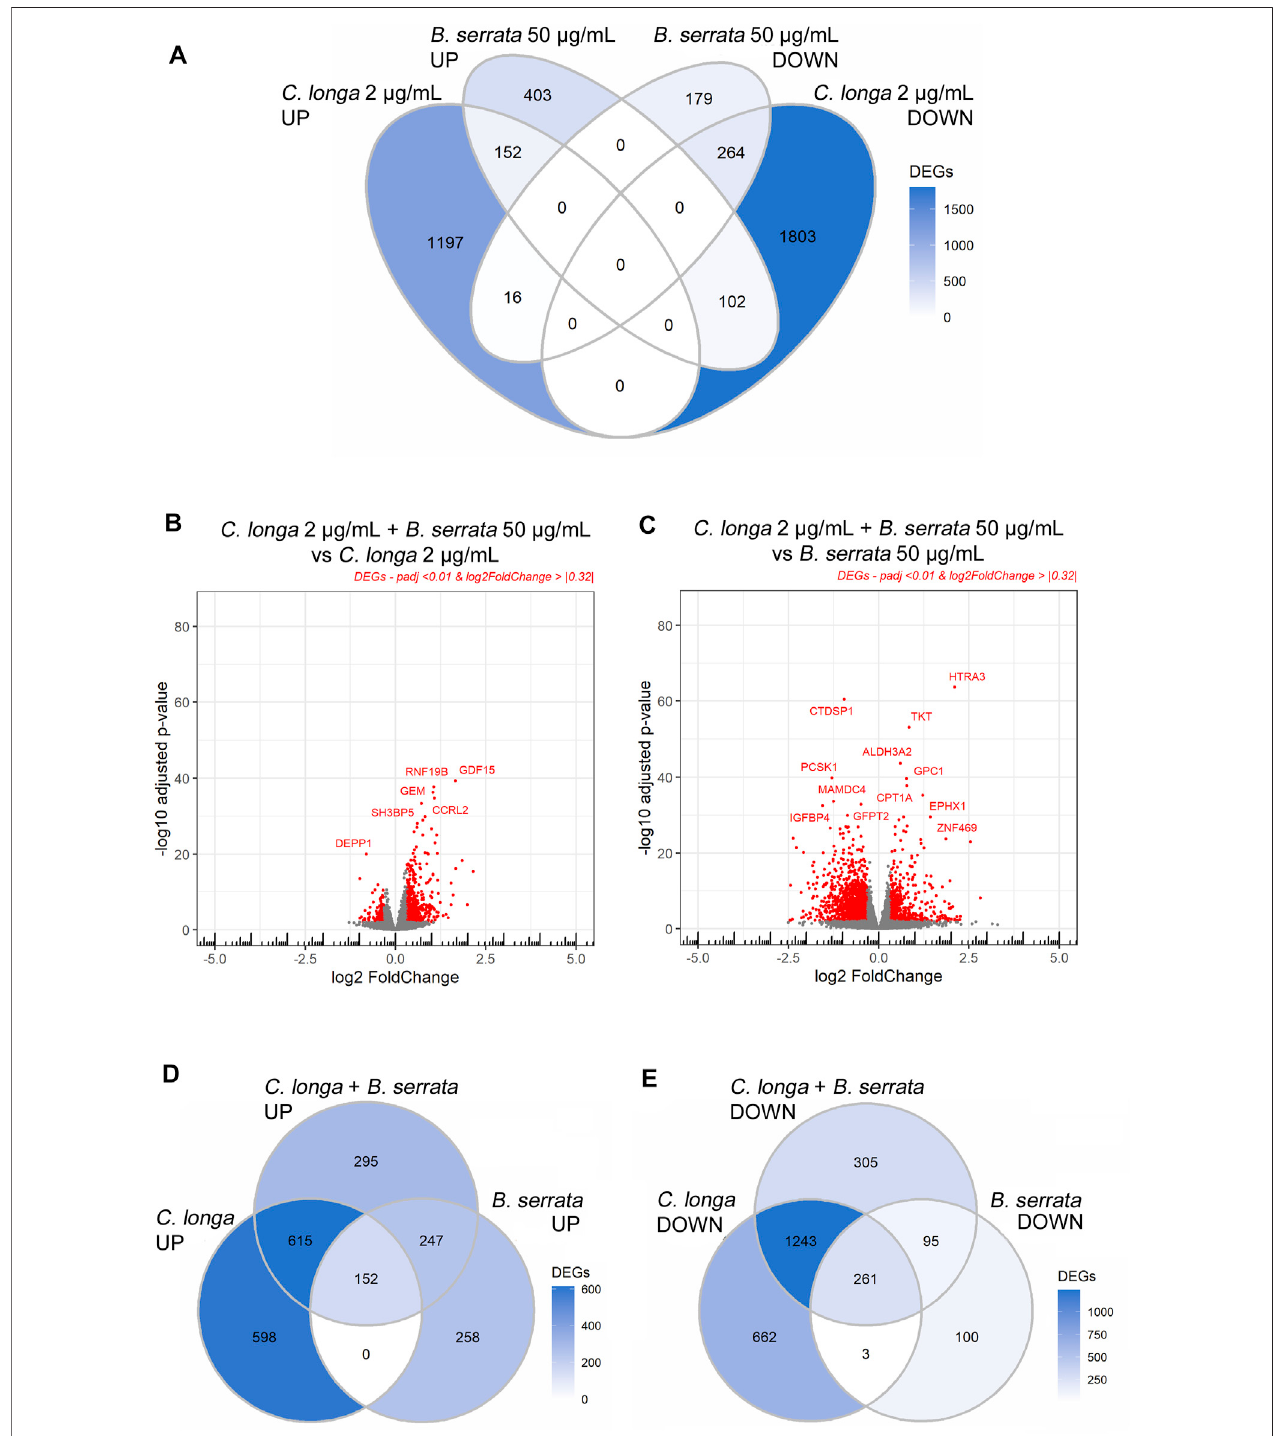
FIGURE 3 | Volcano plots and Venn diagrams of C. longa 2 μ g/ml, B. serrata 50 μ g/ml, and the combination after 24 h treatment on OA chondrocytes. Threshold padj < 0.01 and Log2FoldChange > |0.32|, n = 10.